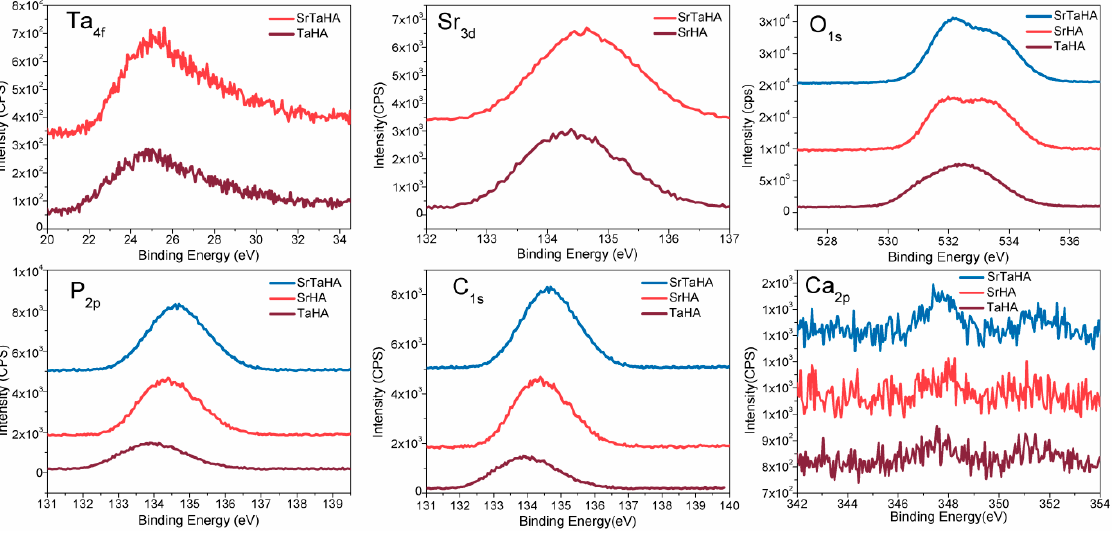
Figure 11. XPS spectra of various elements present in all the coated materials at selected binding energy region.